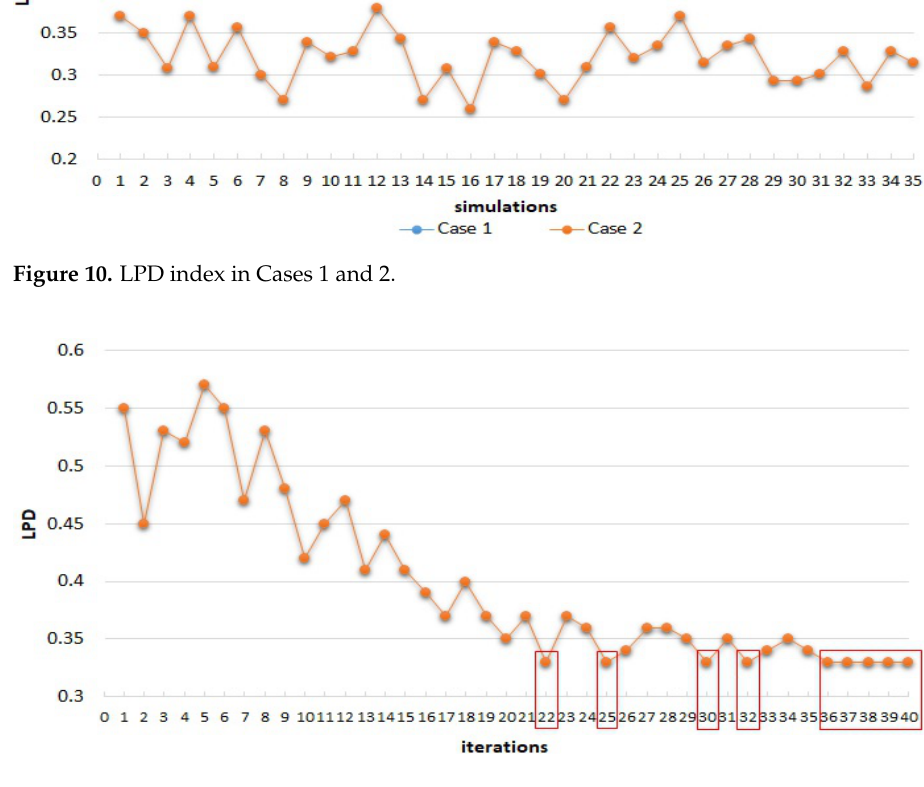
Figure 11. LPD index in Case 2 at simulation nr.1.